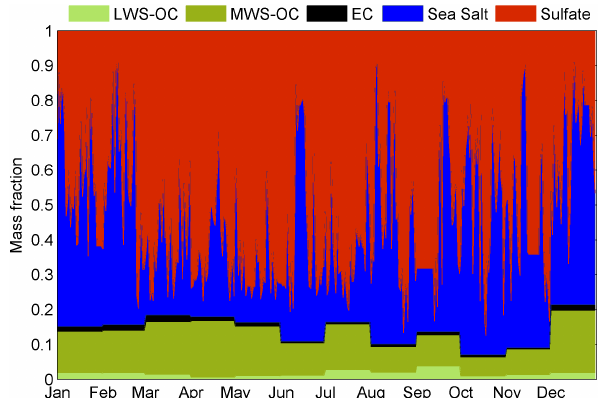
Figure 3. The averaged chemical composition for year 2008 at the Zeppelin station based on filter measurements, on a daily basis for inorganics (sea salt and sulfate) and monthly basis for organics (LWS-OC, MWS-OC,